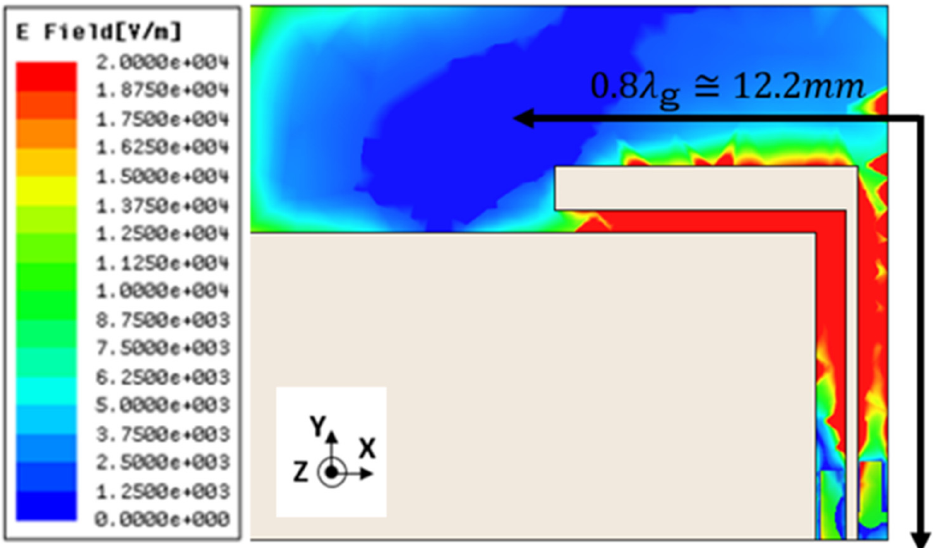
Figure 2. Electric field strength distribution on surface metal (9.0 GHz). A strong electric field distribution can be confirmed in the figure from the feeding point along the L-shaped slot.